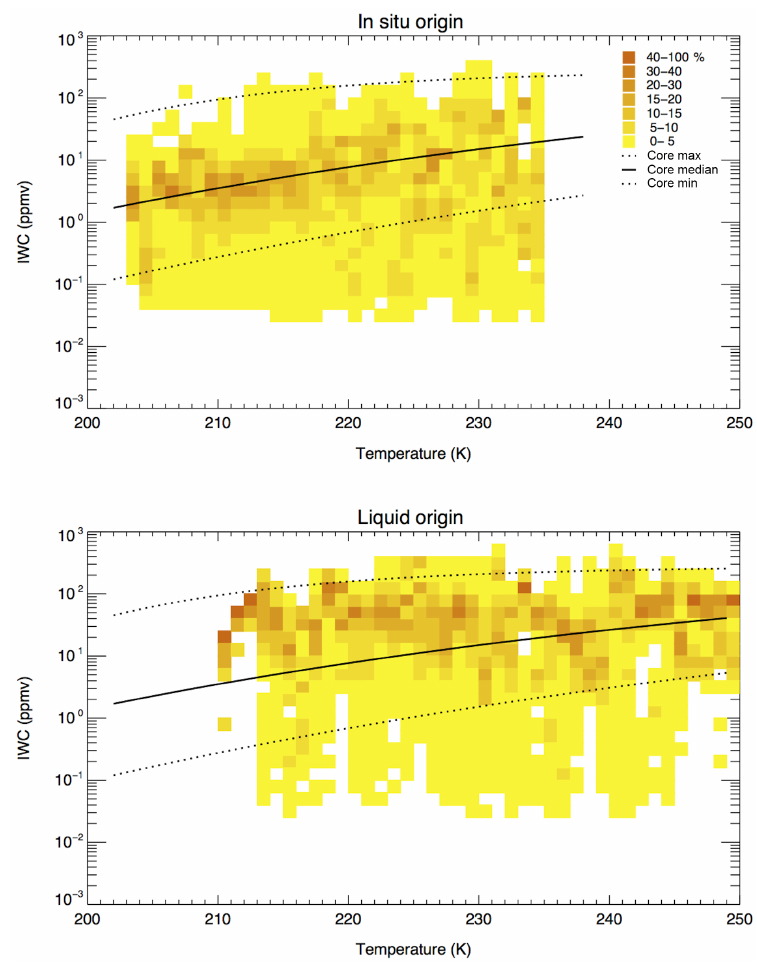
Figure 6. The frequency of IWC observations as a function of temperature. IWC is plotted in 1K temperature bins for in situ origin (top) and liquid origin (bottom) data. The core max, median, and core min lines (black) are from Schiller et al.